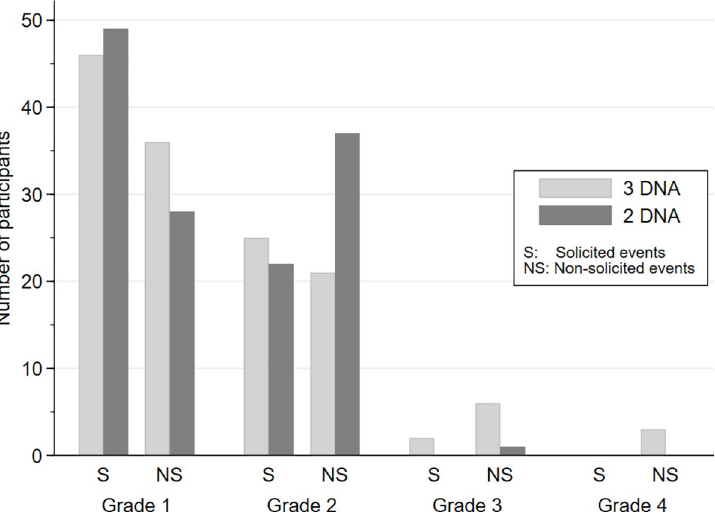
Fig 2. Frequencies of participants with solicited and non-solicited events per vaccine groups, EV03/ANRS VAC20 Phase I/II Trial. The maximum grade is shown per participant and event category. Differences between groups: p = 0.32 and p = 0.56 for solicited and non-solicited events, respectively (rank tests). https://doi.org/10.1371/journal.ppat.1008522.g002 response � 200 SFU/10 6 cells. Globally, the frequency of CD4 + T cells producing at least one cytokine to at least one HIV pool was detected in 68% of vaccinees. The majority of CD4 + T cell responses was directed against Env (72% and 56% in 3xDNA and 2xDNA groups, respec- tively) while only 9% were directed to Gag/Pol/Nef. The magnitude of CD4 + T cell responses (median [IQR]) was 0.66% [0.55–0.86] without difference between groups (Fig 4A). For CD8 + T cell responses, 38% of vaccinees were responders to at least one HIV pool and the magnitude (median [IQR]) was 0.50% [0.40–0.72] without difference between groups. In each group, 28–30% of vaccinees responded to Env and 13–16% to Gag/Pol/Nef (Fig 4B). The analysis of polyfunctionality showed that, among HIV-specific CD4 + and CD8 + T cells, 33% and 15% produced at least 2 cytokines, respectively (Fig 4C). We investigated the cytokine profile of vaccine-elicited cellular responses more broadly using a cytokine multiplex analysis in 49 participants who had completed the vaccine schedule (n = 29 3xDNA group, n = 20 2xDNA group). Fig 5 illustrates p values for W0-W26/28 com- parisons. For both groups of participants, a significantly higher production of Th1 (IFN- γ , IL- Table 2. Proportions of responders to any peptide pool (Env and/or Gag/Pol or Nef; Overall responses), to Env pools (Env) or Gag/Pol/Nef (Gag/Pol/Nef) at weeks (26/28; primary time points) and week 48 and 72, EV03/ANRS VAC20 Phase I/II Trial. Pools Week 26 Week 28 Week 48 Week 72 3 DNA 2